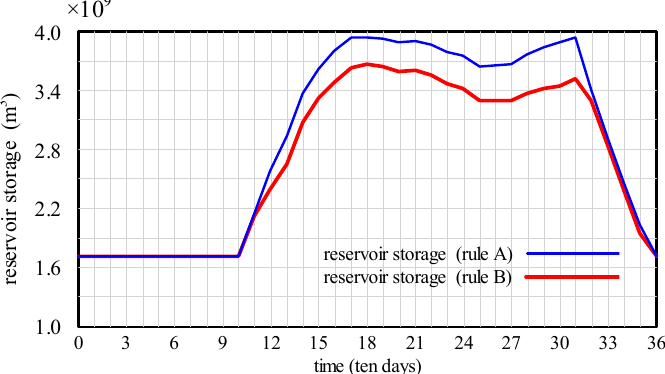
Figure 12. Reservoir storage process of TGR decided by operating rules A and B (the operating horizon is 11 June 2001 to 11 June 2002).